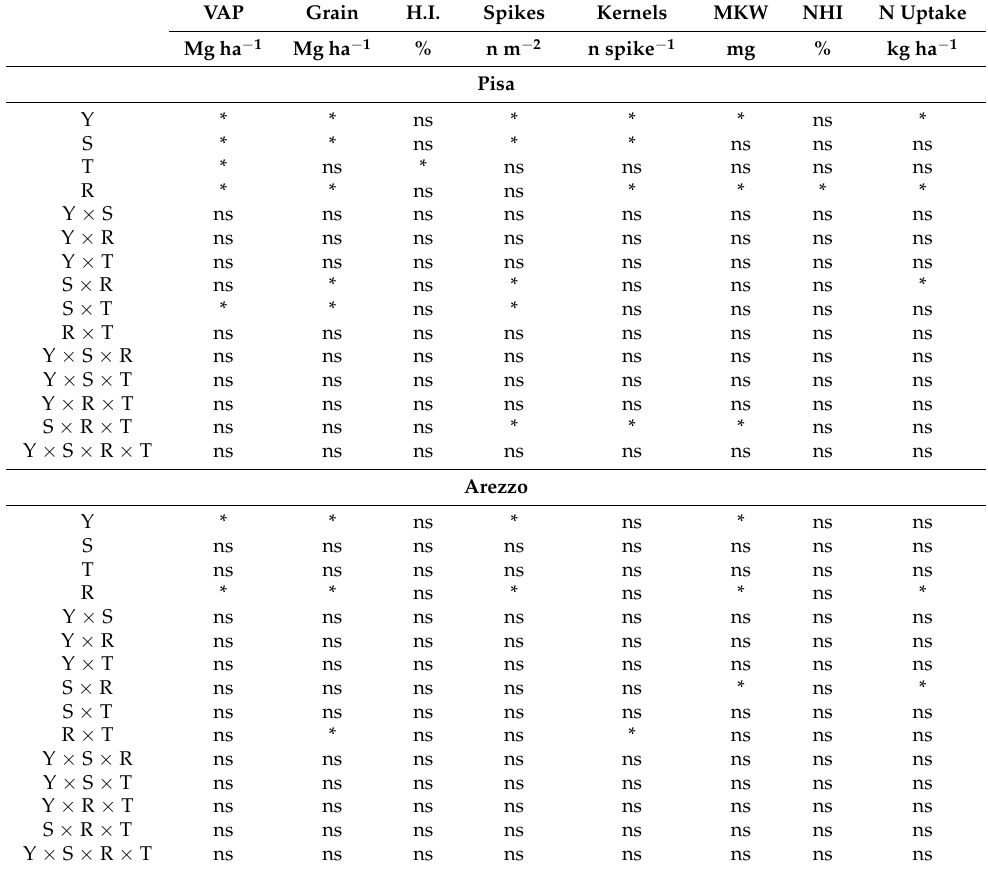
Table 2. Results of ANOVA for durum wheat vegetative above-ground part (VAP), grain yield, yield components, and NHI and N uptake as affected by Year (Y), N source (S), N timing (T), N rate (R), and their interactions at the two locations. * = significant at 0.05 level; ns =